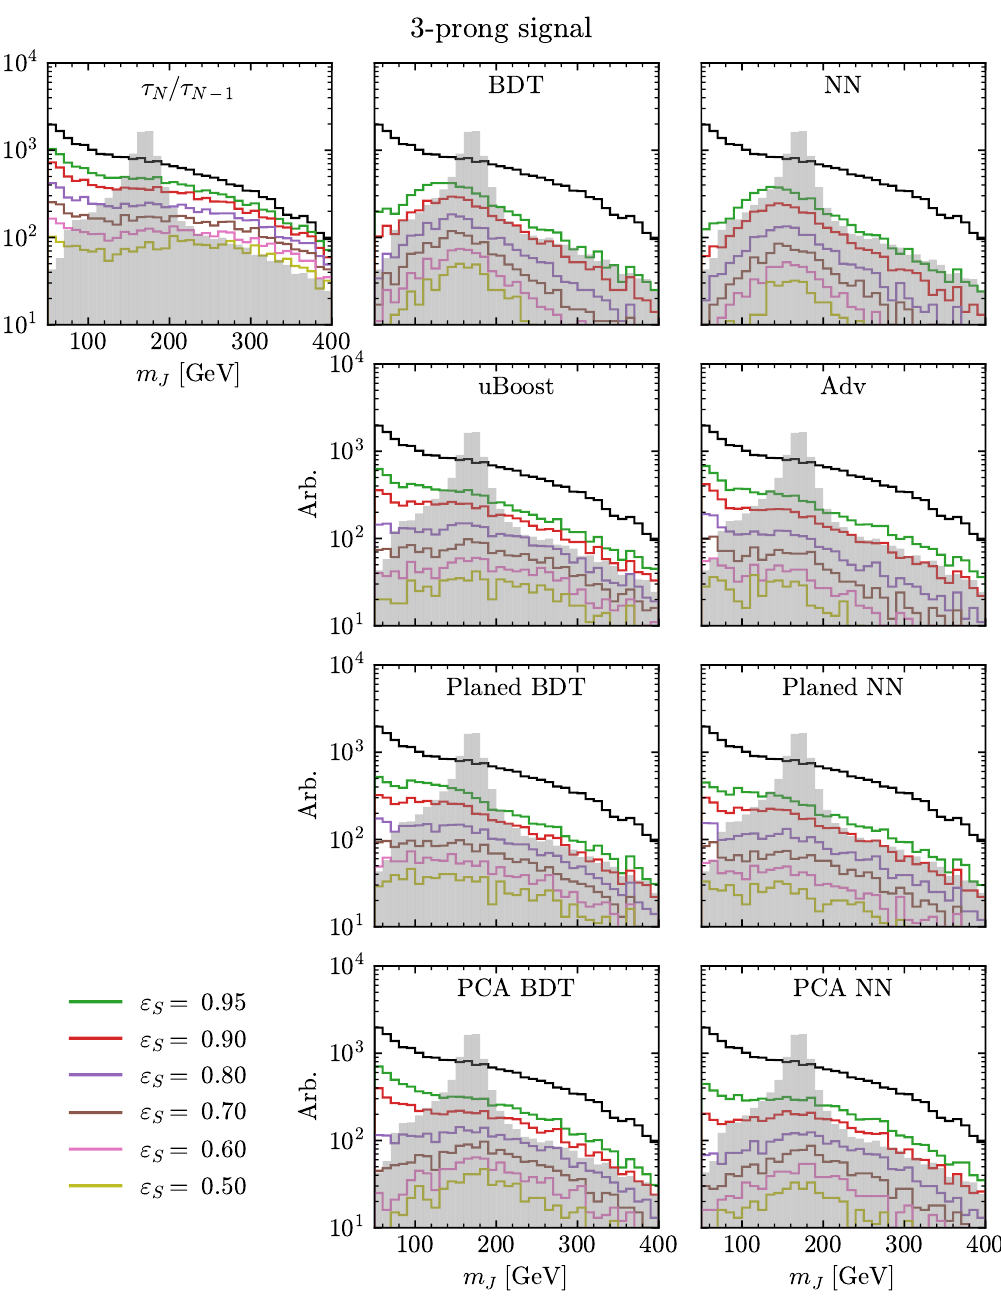
Figure 19: Comparison of all decorrelation methods to the benchmarks for the 3- prong signal. τ